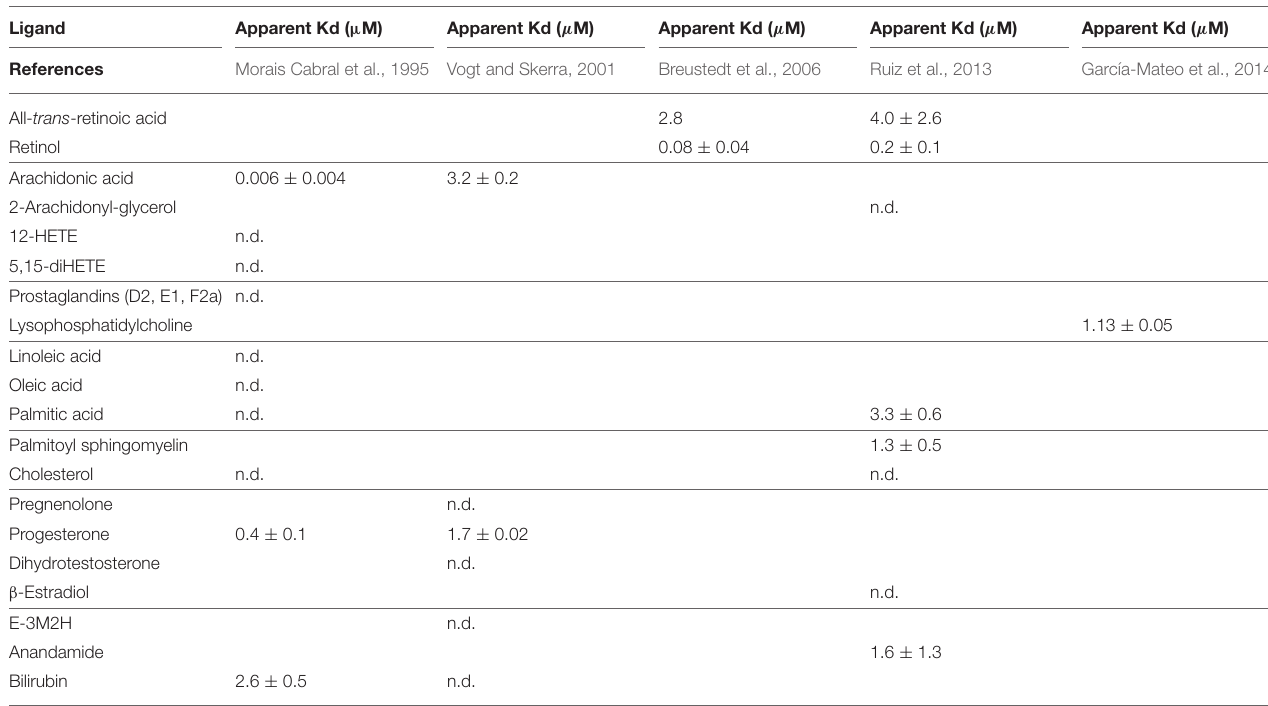
TABLE 2 | ApoD ligand binding in vitro